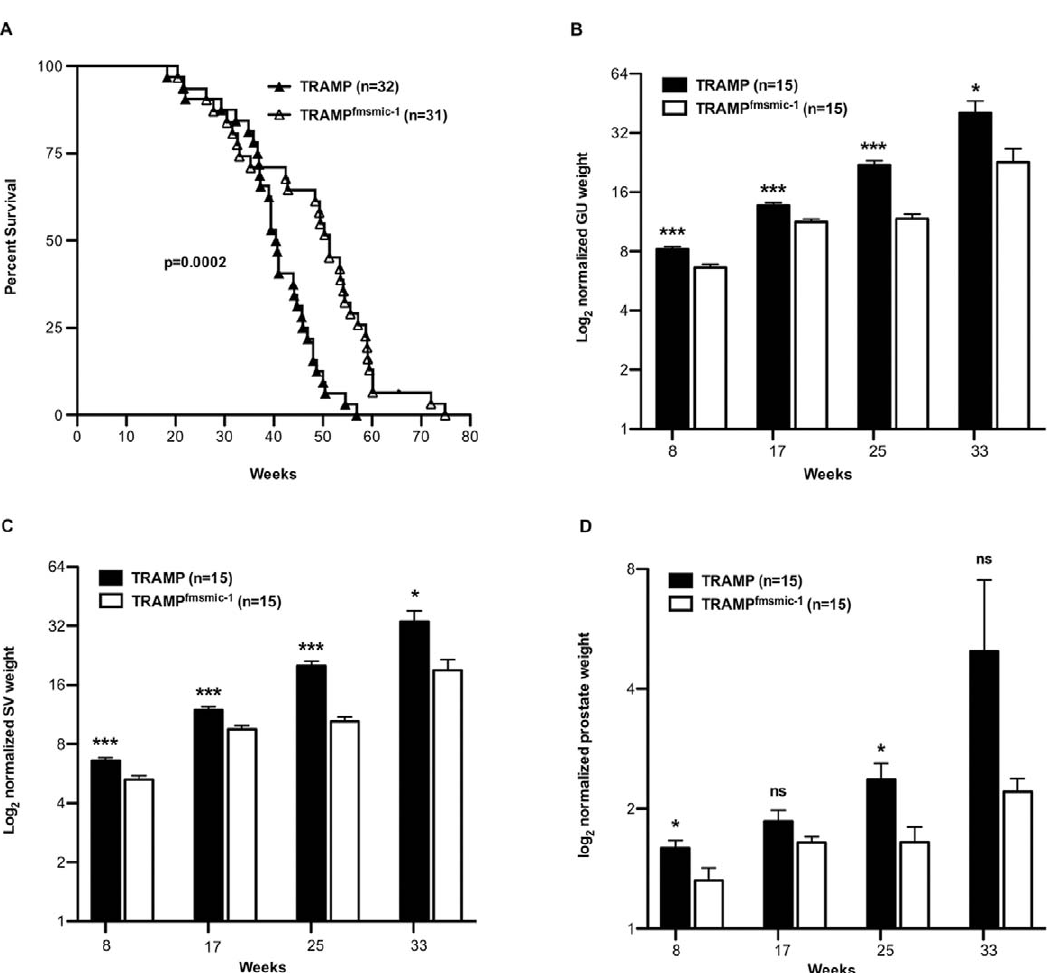
Figure 1. TRAMP fmsmic-1 mice survive longer and have smaller prostate tumors than TRAMP mice. Overall survival of individual mice from birth to death is shown (panel A). The survival data for TRAMP (— m —) and TRAMP fmsmic-1 (— D —) mice were plotted using the Kaplan-Meier method. The log-rank statistic for median survival time is shown. The genitourinary (GU), seminal vesicle (SV) and prostate tumor sizes in TRAMP fmsmic-1 and TRAMP mice (n=15/group) sacrificed at 8, 17, 25 and 33 weeks of age are shown in panel B, C and D. The GU (panel B), SV (panel C) and prostate weights (panel D) are presented as mean mg weight/g body weight 6 SEM. p values are shown as *p , 0.05; **p , 0.01; ***p , 0.001.